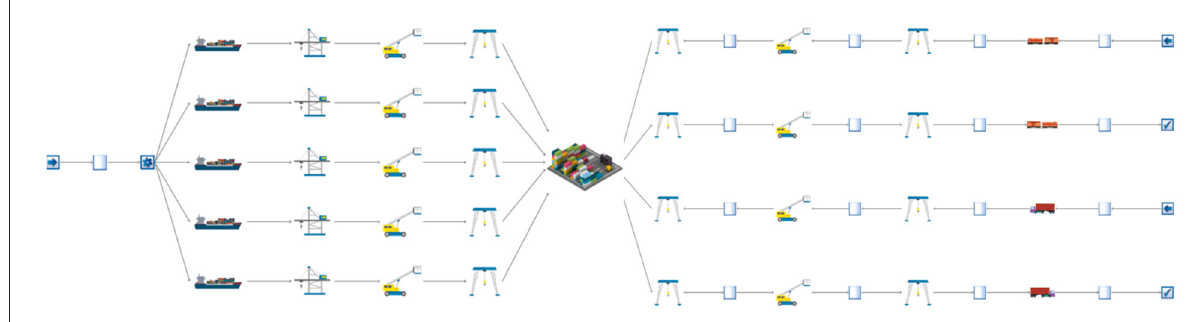
FIGURE5 Overview of Port of Valencia throughput simulation for incoming/outgoing container